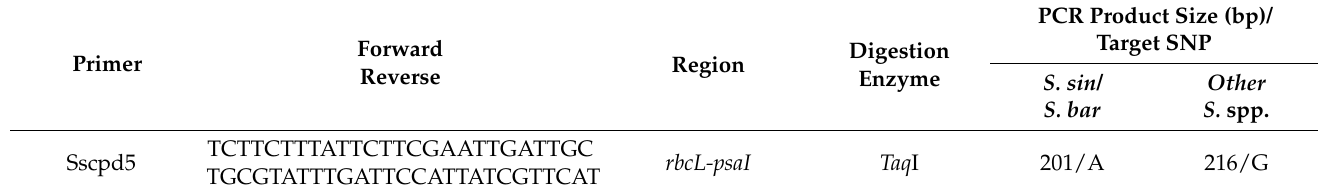
Table 4. dCAPS maker design based on SNPs between S. sinense/S. barberi and other Saccharum species.